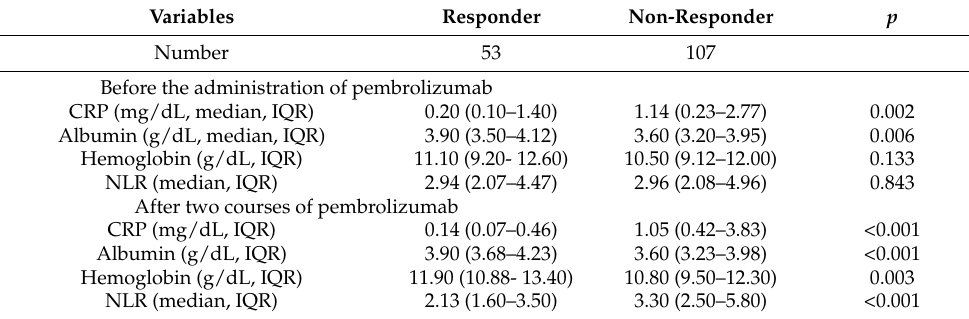
Table 2. Clinical covariates before and after two courses of